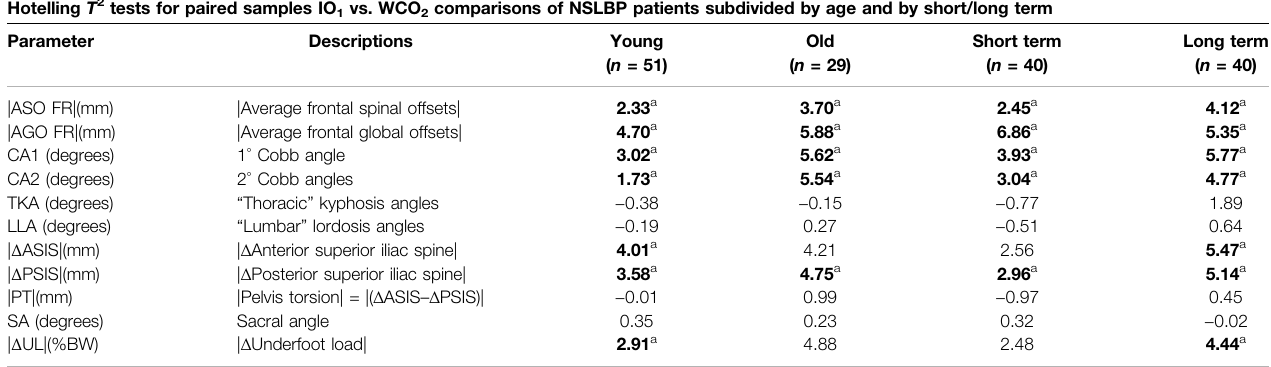
AllHotelling T 2 pairedsamplestestsresultedstatisticallysigni fi cant.Signeddifferencesofmeans:apositivedifferenceindicatesthattheparametermeanvalueatthe fi rsttestedconditionis higher than the parameter mean value at the second tested condition; negative difference indicates the opposite (e.g. the 3.58 value for | Δ PSIS|(mm) in the IO 1 vs. WCO 2 test YOUNG, column indicates that the | Δ PSIS| is higher in IO 1 than WCO 2 ; the − 0.01 value for |PT|(mm) in the same column indicates that |PT|(mm) is higher in WCO 2 than IO 2 . a associated with bold numbers indicates the statistically signi fi cant differences of means.